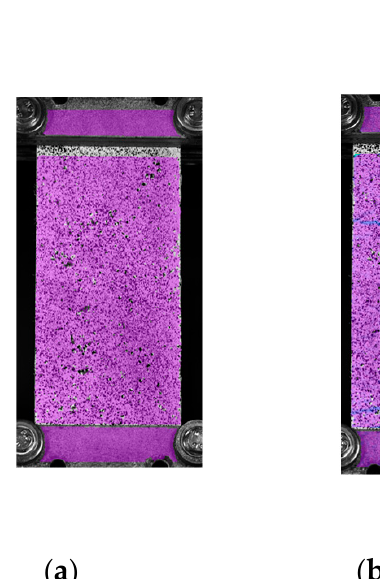
Figure 13. Frames of the DIC measurement of C-F/TRC specimen 3 at the beginning ( a ), the first crack ( b ), the end of stage 3 ( c ) and at the beginning of stage 4 ( d ). The color scale represents the grade of the major principal strains, from 0.0229 units in red to − 0.00059 units in purple.